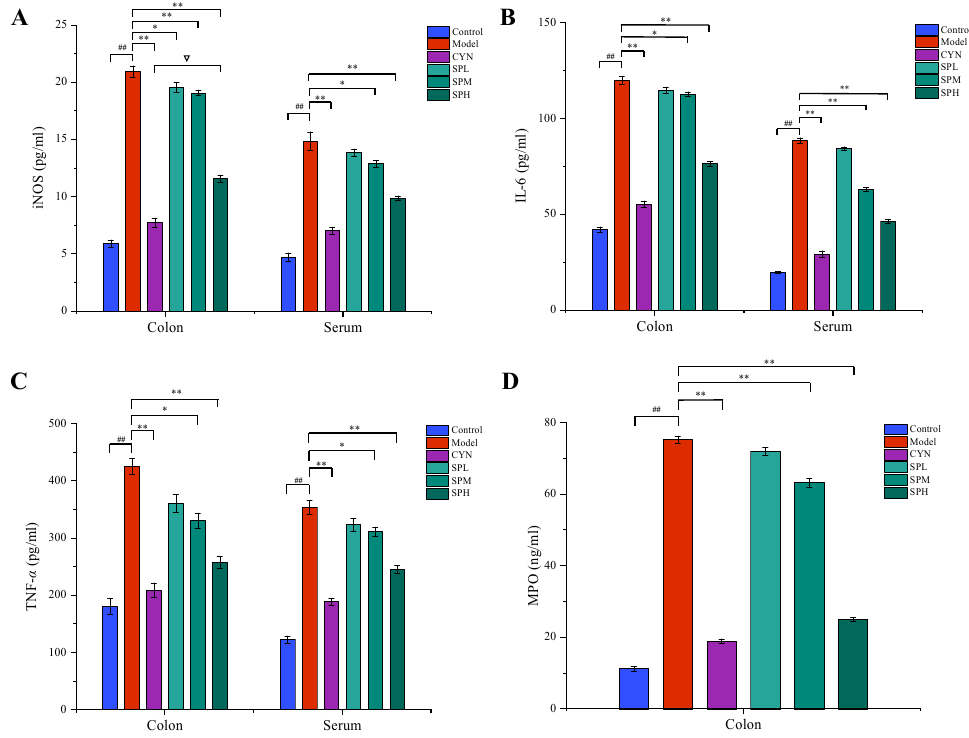
Figure 3. Effect of SP on ( A ) body weight, ( B ) disease activity index, ( C ) colon length and ( D ) spleen coefficient. (Data are expressed as the means ± S.E.M., n = 10). Compared with control group, ## p < 0.01; compared with model group, * p < 0.05, ** p < 0.01; compared with CYN group, ∇ p >